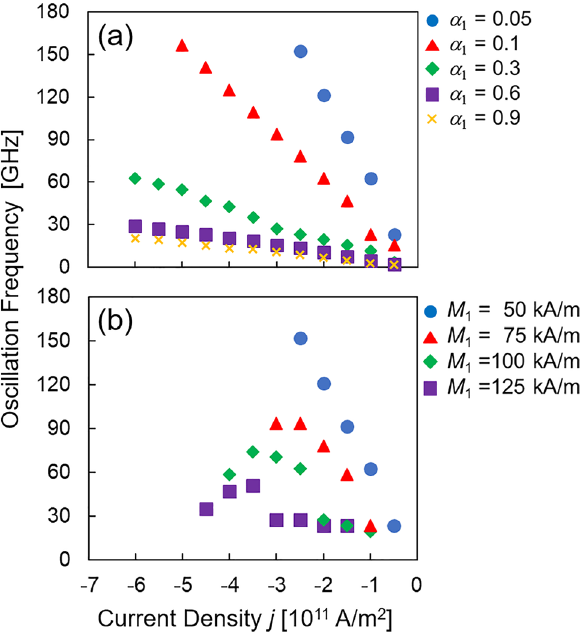
Figure 5. ( a ) Plot of f as function of j for α 1 = 0.05, 0.1, 0.3, 0.6, and 0.9, with J 1 , J 2 , and M 1 fixed to 0.6 and − 0.6 mJ/m 2 , and 50 kA/m, respectively. ( b ) Plot of f as function of j for M 1 = 50, 75, 100, and 125 kA/m, with J 1 , J 2 , and α 1 fixed to 0.6 and − 0.6 mJ/m 2 , and 0.05,